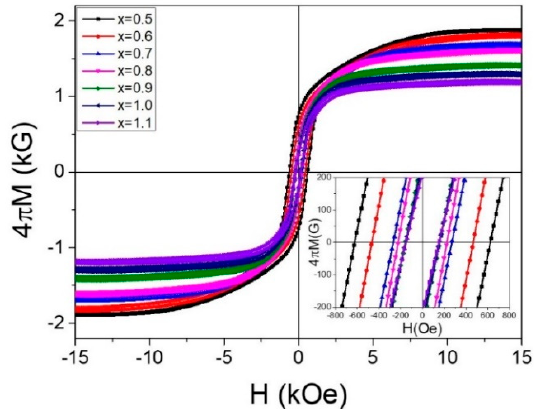
Figure 5. M ‐ H curve of SrFe 12 − 2x Zn x Zr x O 19 –epoxy composition ( x = 0.5, 0.6, 0.7, 0.8, 0.9, 1.0, 1.1) sam ‐ ples calcined at 1250 °C ( − 15 kOe ≤ H ≤ 15 kOe). Table 2. Saturation magnetization (4 π M S ), coercivity (H C ), real ( ε′ ) and imaginary ( ε″ ) parts of permittivities at 1 GHz, real part of permeability ( μ s ′ ) at steady region (at 3 GHz), frequencies of maximum μ″ values ( f FMR ), minimum RLs (RL min ), and frequencies of RL min ( f RLmin ) of SrFe 12 − 2x Zn x Zr x O 19 ( x = 0.5, 0.6, 0.7, 0.8, 0.9, 1.0, 1.1) powder–epoxy (10 wt%) composite sam ‐ ples.